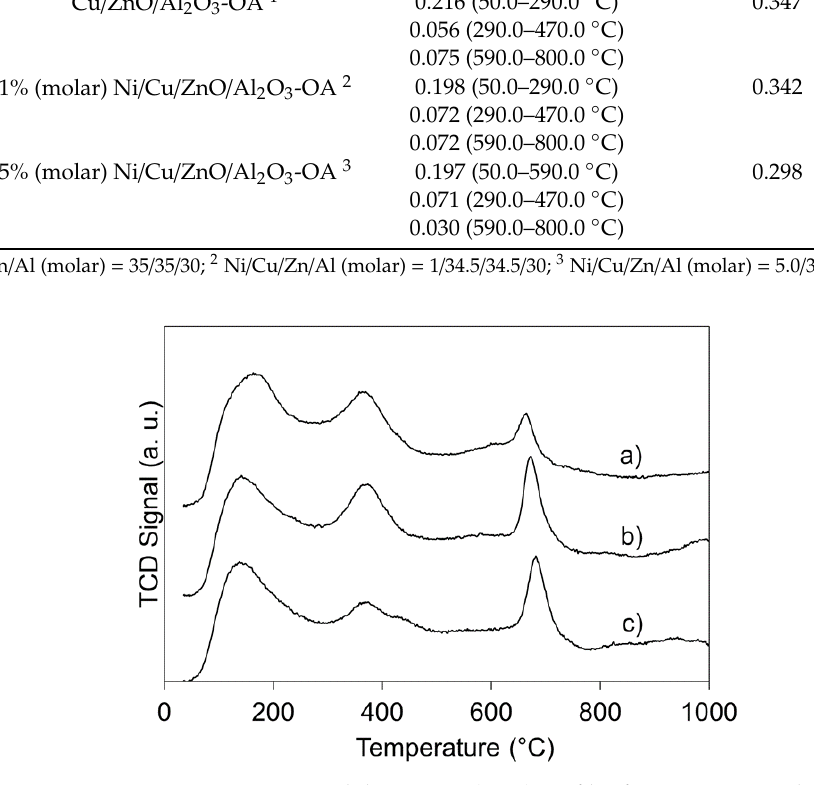
Figure 2. NH 3 temperature programmed desorption (TPD) profiles for Ni/Cu/ZnO/Al 2 O 3 -OA with different amounts of Ni loading (molar). ( a ) Ni/Cu/Zn/Al (molar) = 5/32.5/32.5/30, ( b ) Ni/Cu/Zn/Al (molar) = 1/34.5/34.5/30, ( c ) Cu/Zn/Al (molar) = 35/35/30. Conditions: 5%NH 3 balanced by Ar, 120 mg catalyst, temperature ramp 5 °C/min, flow rate 30 mL/min. All traces have been displaced for clarity.